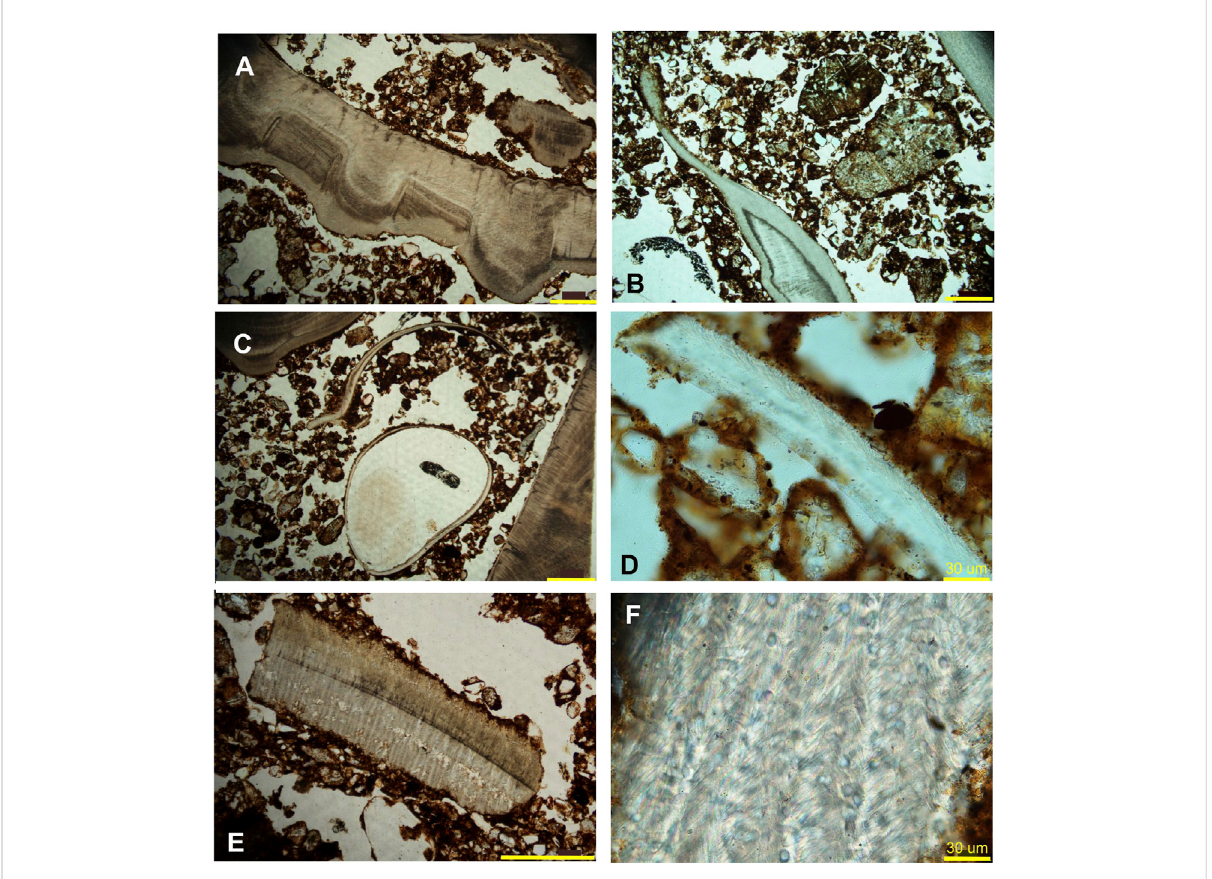
FIGURE 7 Micropictographs of bone fragments in the Old Geos pro fi le, including (A) Tegillarca sp. shell, (B) Terebralia sp. shell, (C) unidenti fi ed shell, (D) unburnt eggshell, (E) decalci fi ed shell fragment, and (F) microbial borings within a shell fragment. Yellow scale bar is 600 µm unless otherwise